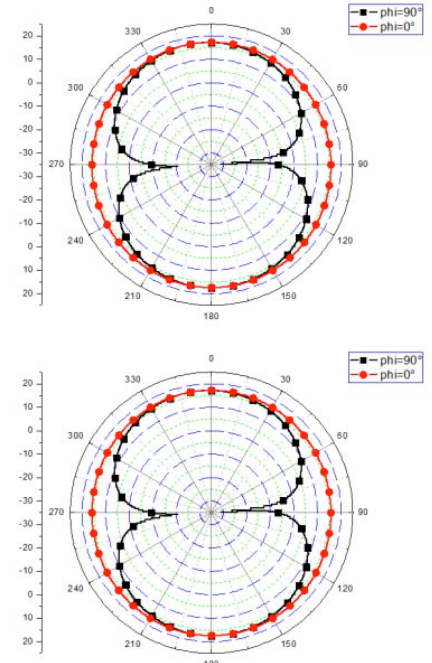
Fig.3. Simulated radiation pattern of E-plane of the proposed antenna at a) 2.44GHz b) 5.27 GHz.